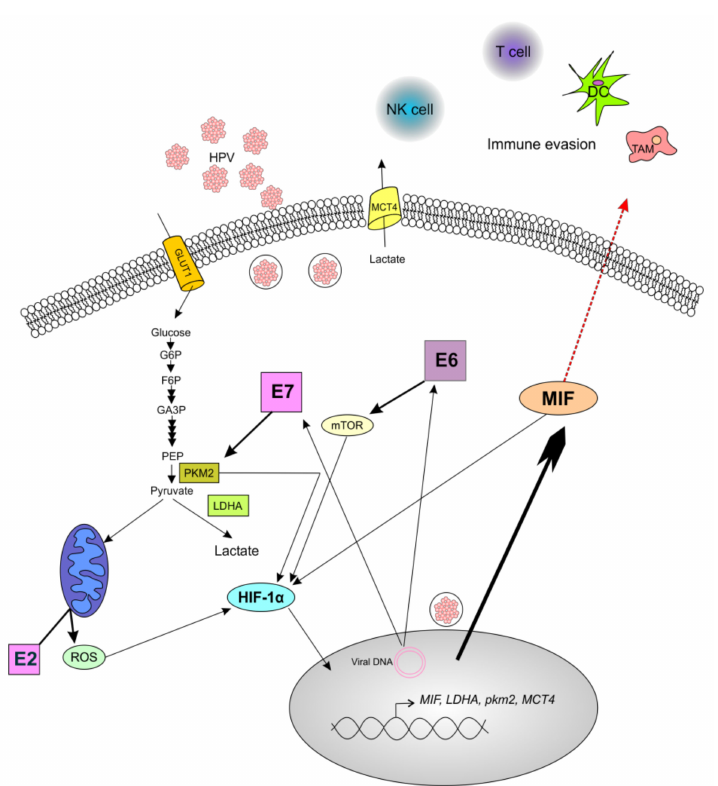
Figure 6. Schematic illustration of the role of human papilloma virus (HPV) oncoproteins in the production of macrophage migration inhibitory factor (MIF). The oncoprotein E6 promotes the activation of the mTOR signaling pathway, thus leading to the upregulation of hypoxia inducible factor 1 α (HIF-1 α ), which enhances the production of MIF and increases the production of lactate. The oncoprotein E7 drives the accumulation of the dimeric form of pyruvate kinase M2 (PKM2), thus leading to the conversion of pyruvate to lactate through lactate dehydrogenase (LDHA). Moreover, PKM2 interacts with HIF-1 α to amplify the expression of HIF-1 α target genes, including MIF and LDHA. Additionally, the HPV E2 protein localizes to the mitochondrial membrane, leading to the increased production of reactive oxygen species (ROS), which increases the stability of HIF-1 α . The enrichment of MIF in the extracellular environment could promote the tumor immune escape by the accumulation of pro-tumoral immune cells such as tumor-associated macrophages (TAM), and by the decrease in antitumoral cells such as cytotoxic T cells, Langerhans/dendritic cells (DC), and natural killer (NK) cells. Complete arrows indicate data from the literature, and the red dotted arrow indicates a